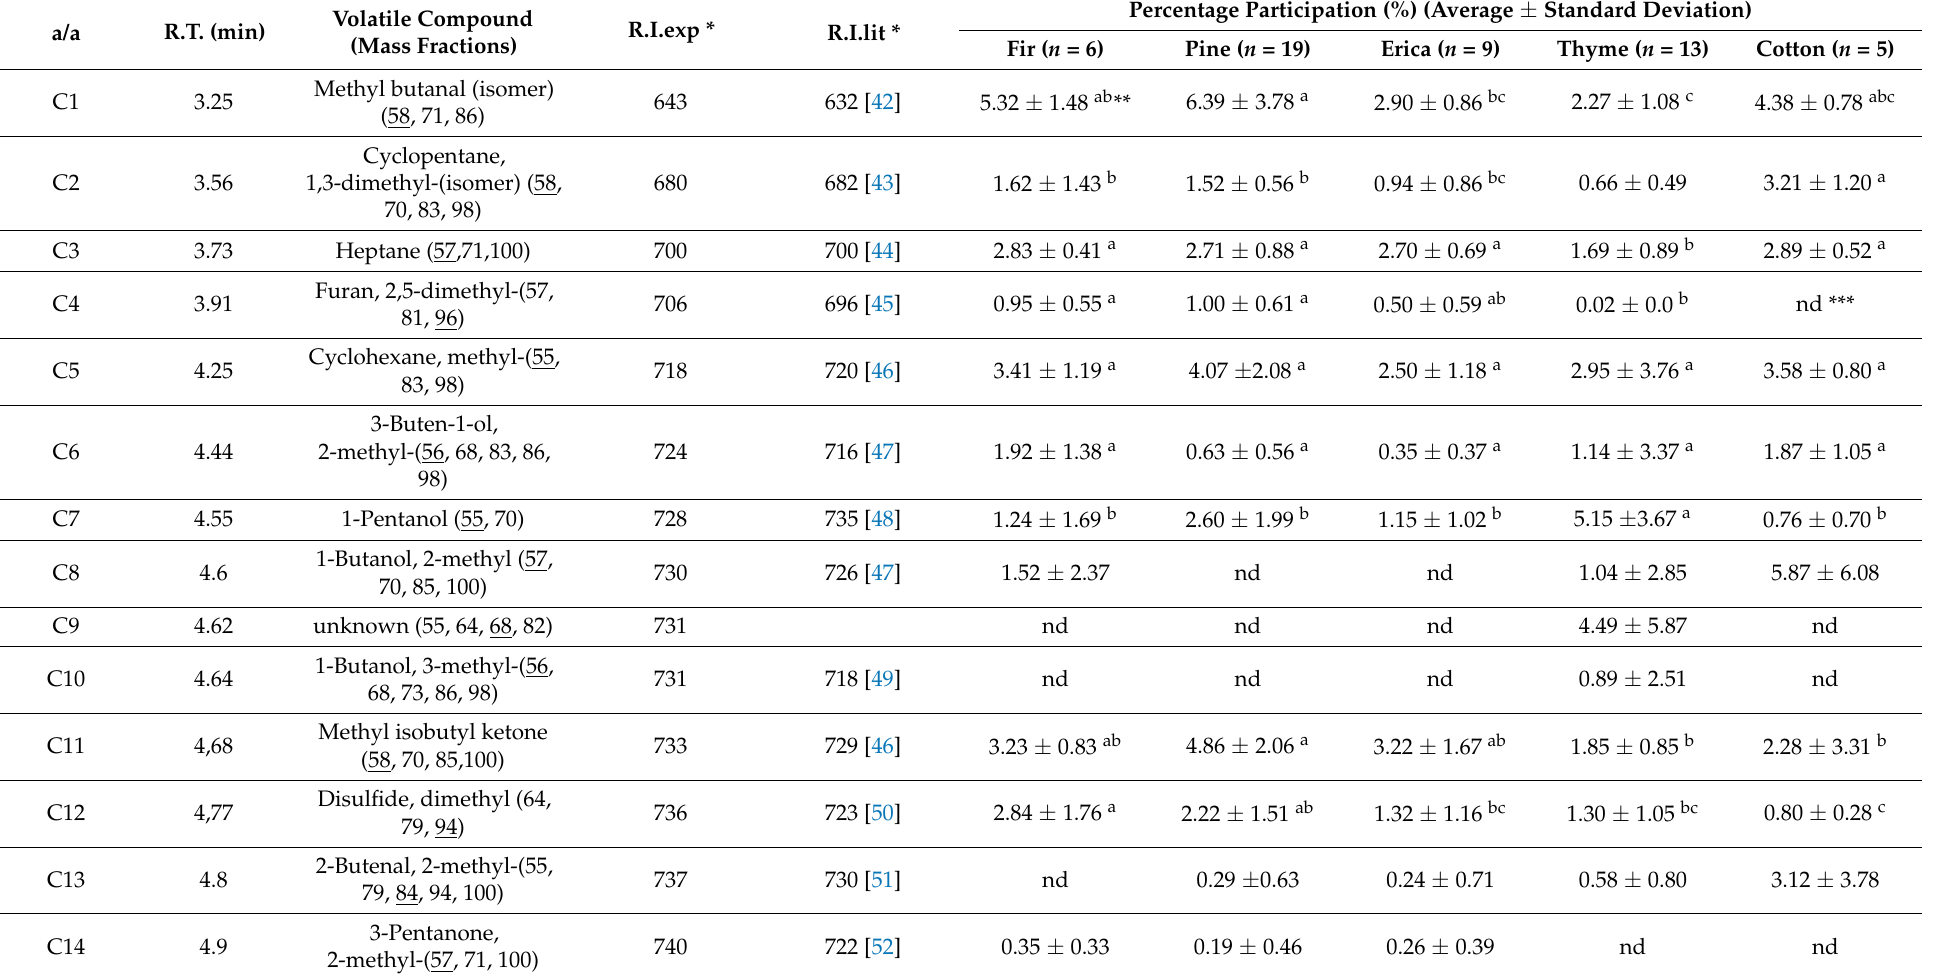
Table 1. Percentage participation (%) of volatile compounds found in Greek monofloral honey types (retention time, R.T.; retention indices, RIs; m/z, mass fractions, average and standard